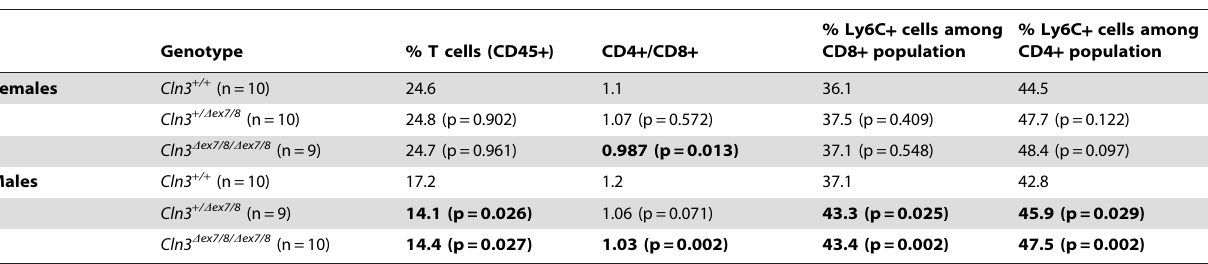
Table 2. T cell frequencies in peripheral blood from Cln3 D ex7/8 mice.